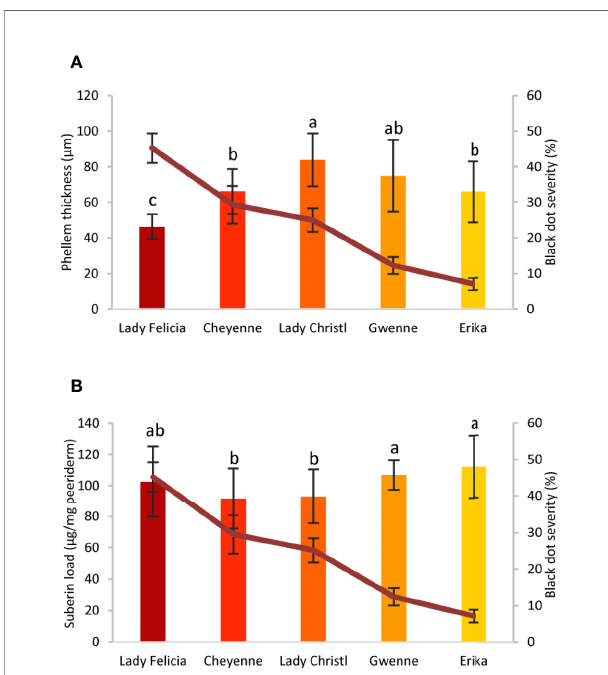
FIGURE 4 | Phellem thickness and suberin concentration of fi ve potato cultivars with different quantitative resistance to black dot. (A) Phellem thickness (µm) measured in semithin sections of asymptomatic regions of a potato tuber grown in the fi eld of fi ve cultivars (n=12, mean ± Standard Deviation). (B) Total suberin amounts (µg/mg periderm) of fi ve potato cultivars grown under controlled conditions in the absence of the fungal pathogen (n=6). Statistically signi fi cant differences in phellem thickness or suberin load are indicated by different letters (p < 0.01, Fisher ’ s LSD). In all graphs, black dot severity is shown in a red line and its axis on the